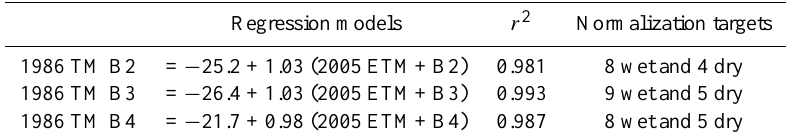
Table 3. Image normalization regression models developed for Choke area image.